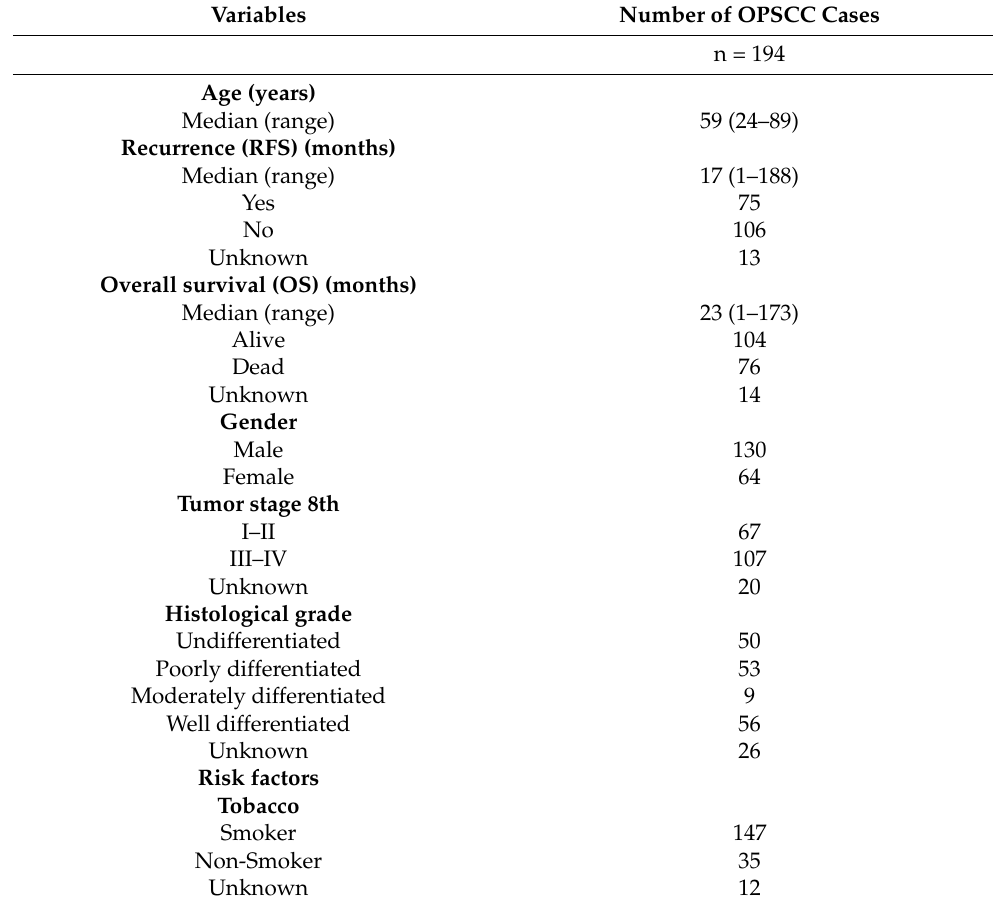
Table 1. Clinical patient